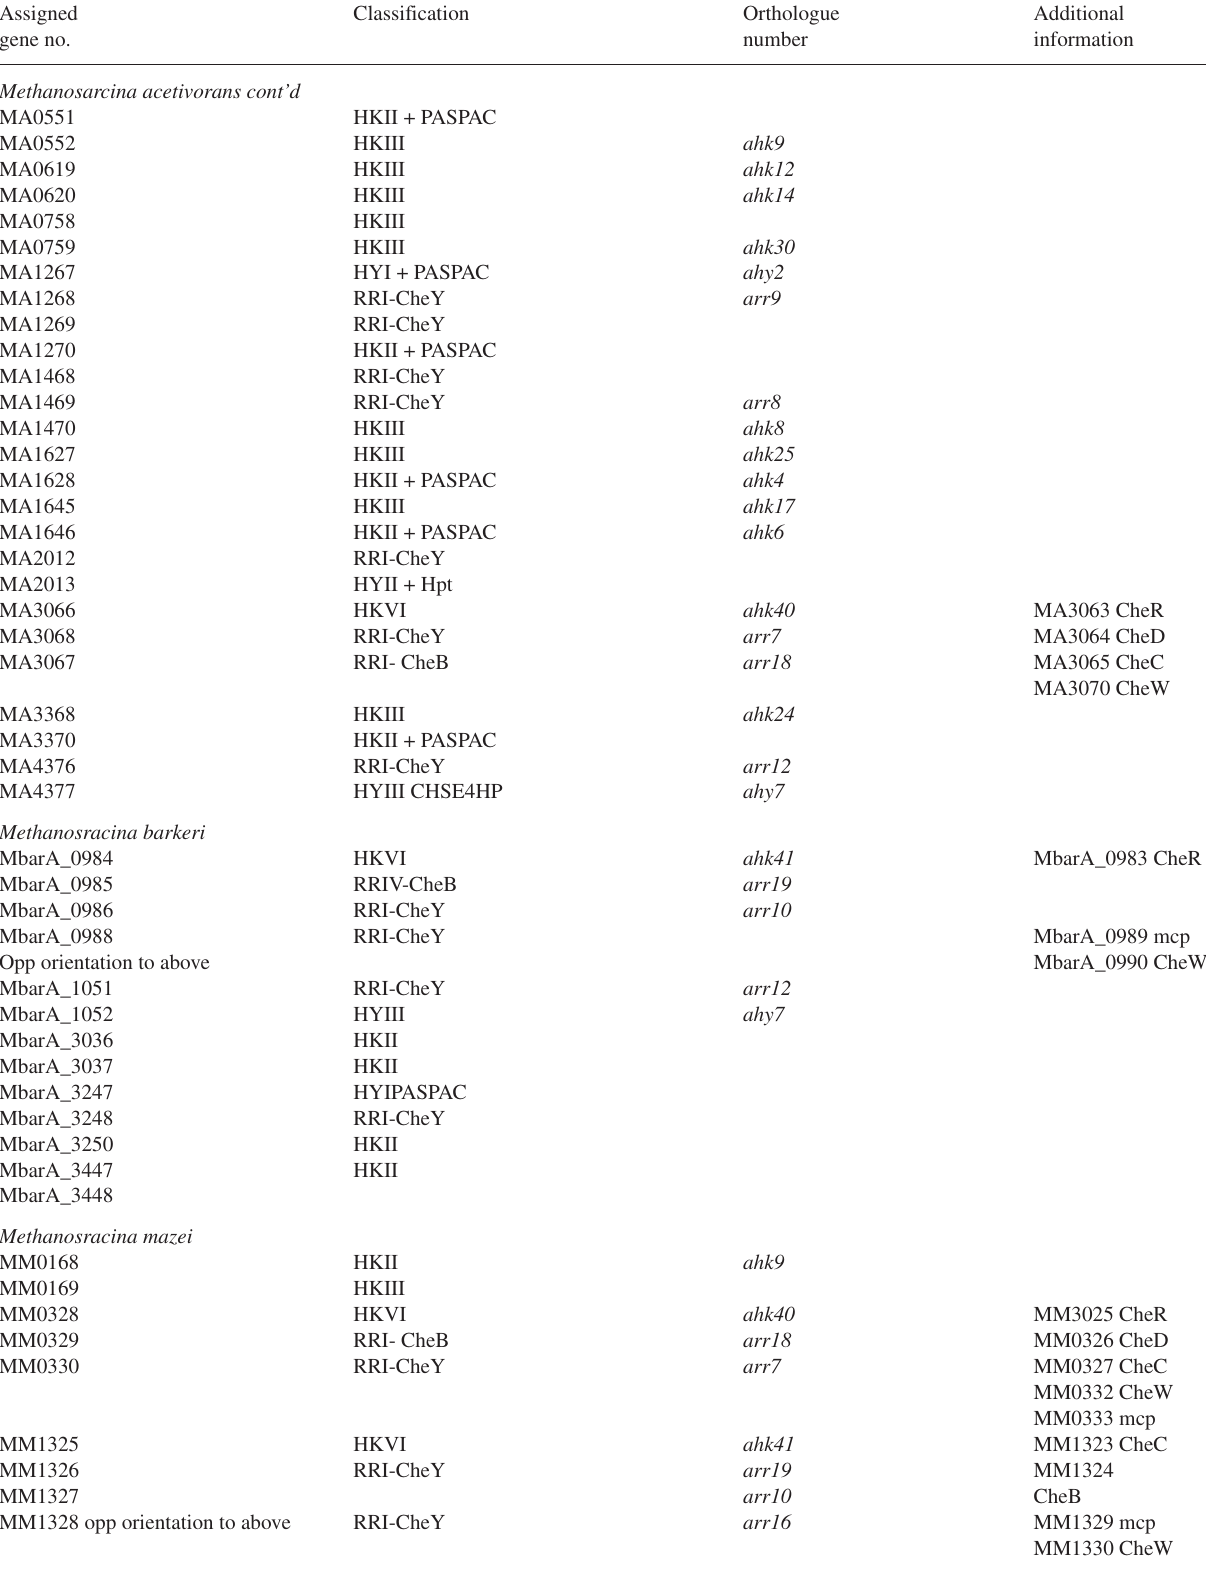
Table A2. Cont’d. Closely linked genes that may be part of operons. Assigned Classification Orthologue Additional gene no. number